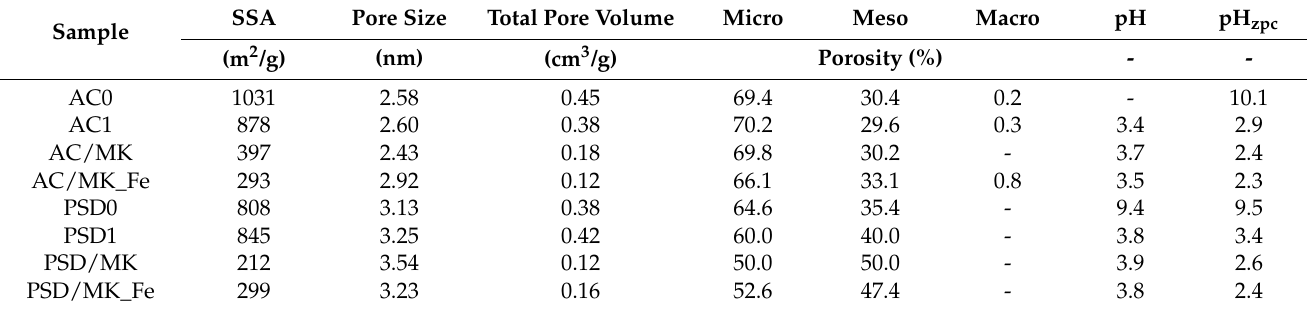
Table 1. Characteristics of the studied